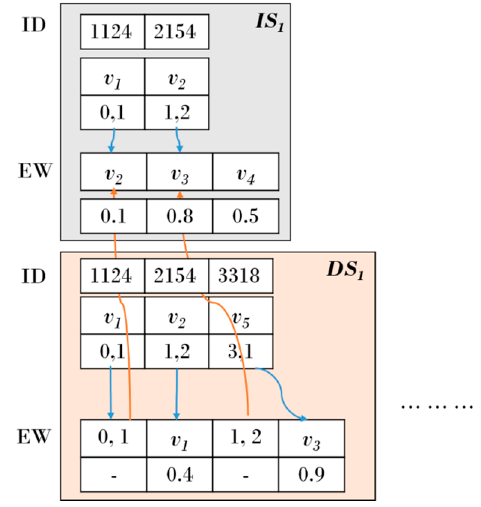
Figure 8. Modified CSR representation.